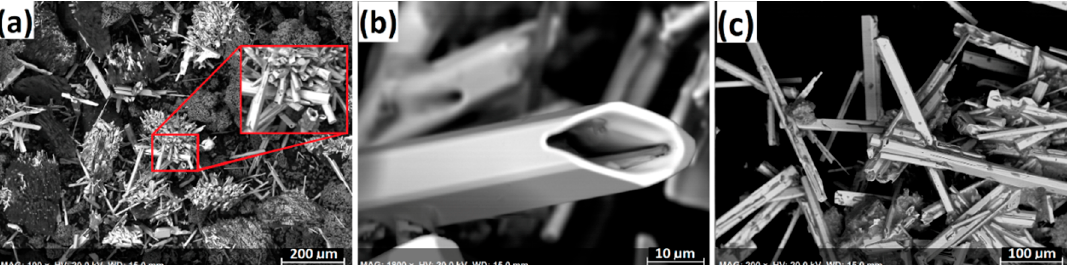
Figure 20. ( a ) Formation of ferrochrome mostly as M 7 C 3 carbide whiskers in the reduced product from the large-scale segregation reduction of 37–75 µm chromite, in which ( b ) hollow hexagonal carbide whiskers were formed, and ( c ) ferrochrome carbide whiskers averaging about 200 µm in length have grown on the inner wall of the crucible during reduction.